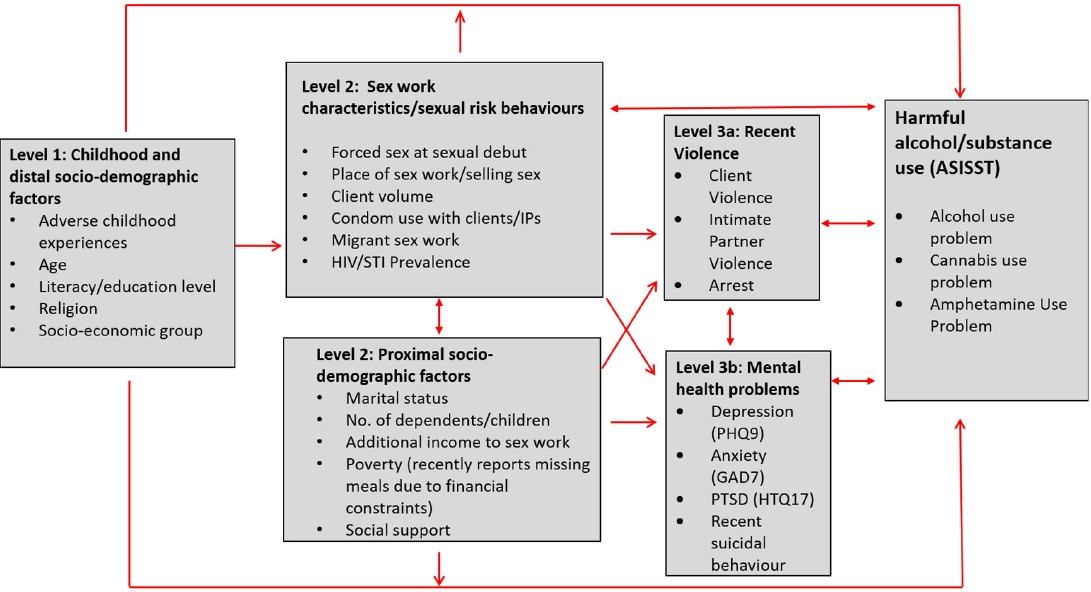
Figure 1. Conceptual framework for exploring risk factors for harmful alcohol and substance use.